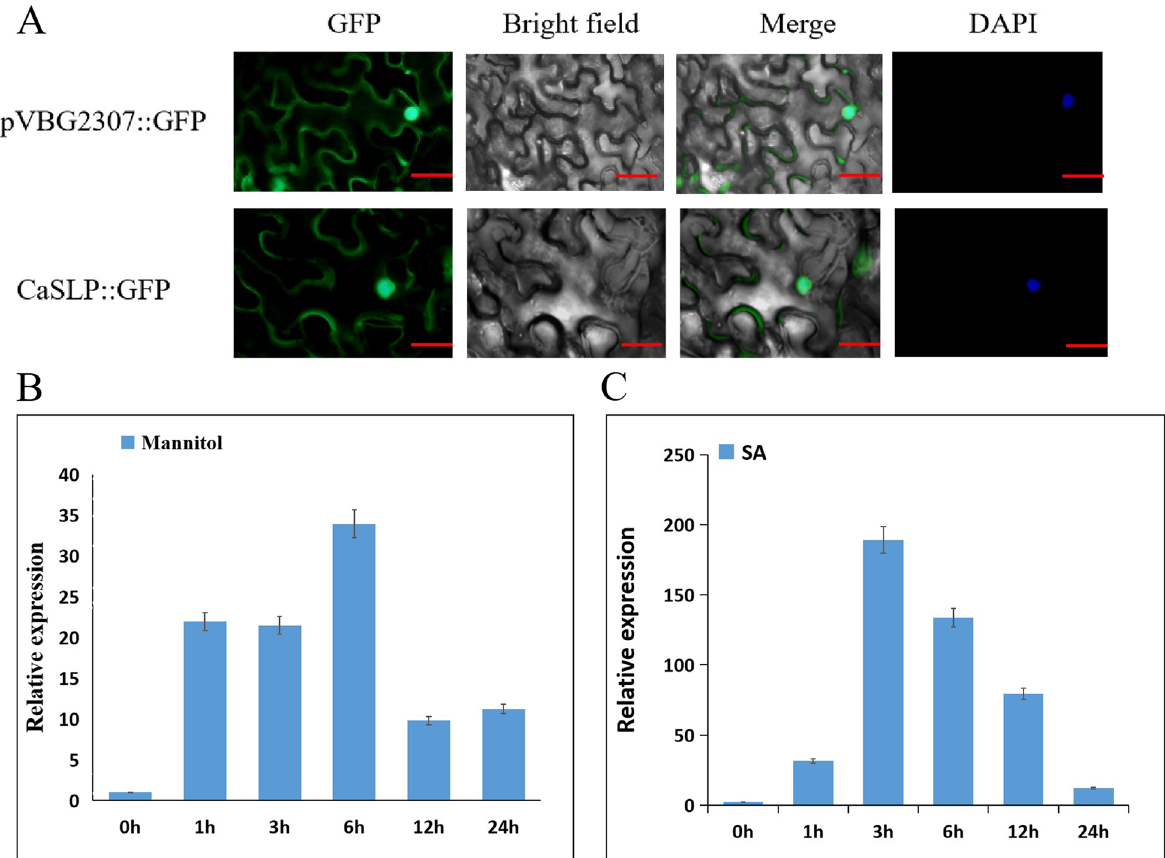
Fig. 1 Subcellular localization of CaSLP and the expression pattern of CaSLP were induced by salicylic acid and drought. A Green fluorescent protein (GFP) control vector (35S:GFP) or CaSLP-GFP fusion protein (35S:CaSLP-YFP) was transiently expressed in Nicotiana benthamiana leaves. Fully automatic microscopic fluorescence images were acquired under green fluorescence and bright field. Scale bars, 50 μm. B CaSLP transcript levels after drought treatment. The pepper leaves were taken at the 0, 1, 3, 6, 12, and 24 h time points for transcript level analysis. C CaSLP transcript levels under SA treatment. Leaves were acquired at 0, 1, 3, 6, 12, and 24 h time points. Actin was chosen as a control. Error bars show